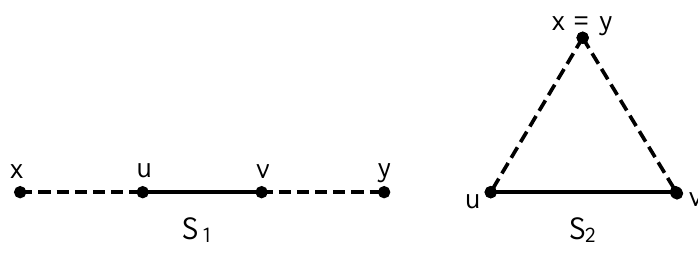
Figure 3. Two forbidden sub signed graphs for a sign-compatible signed graph [13].